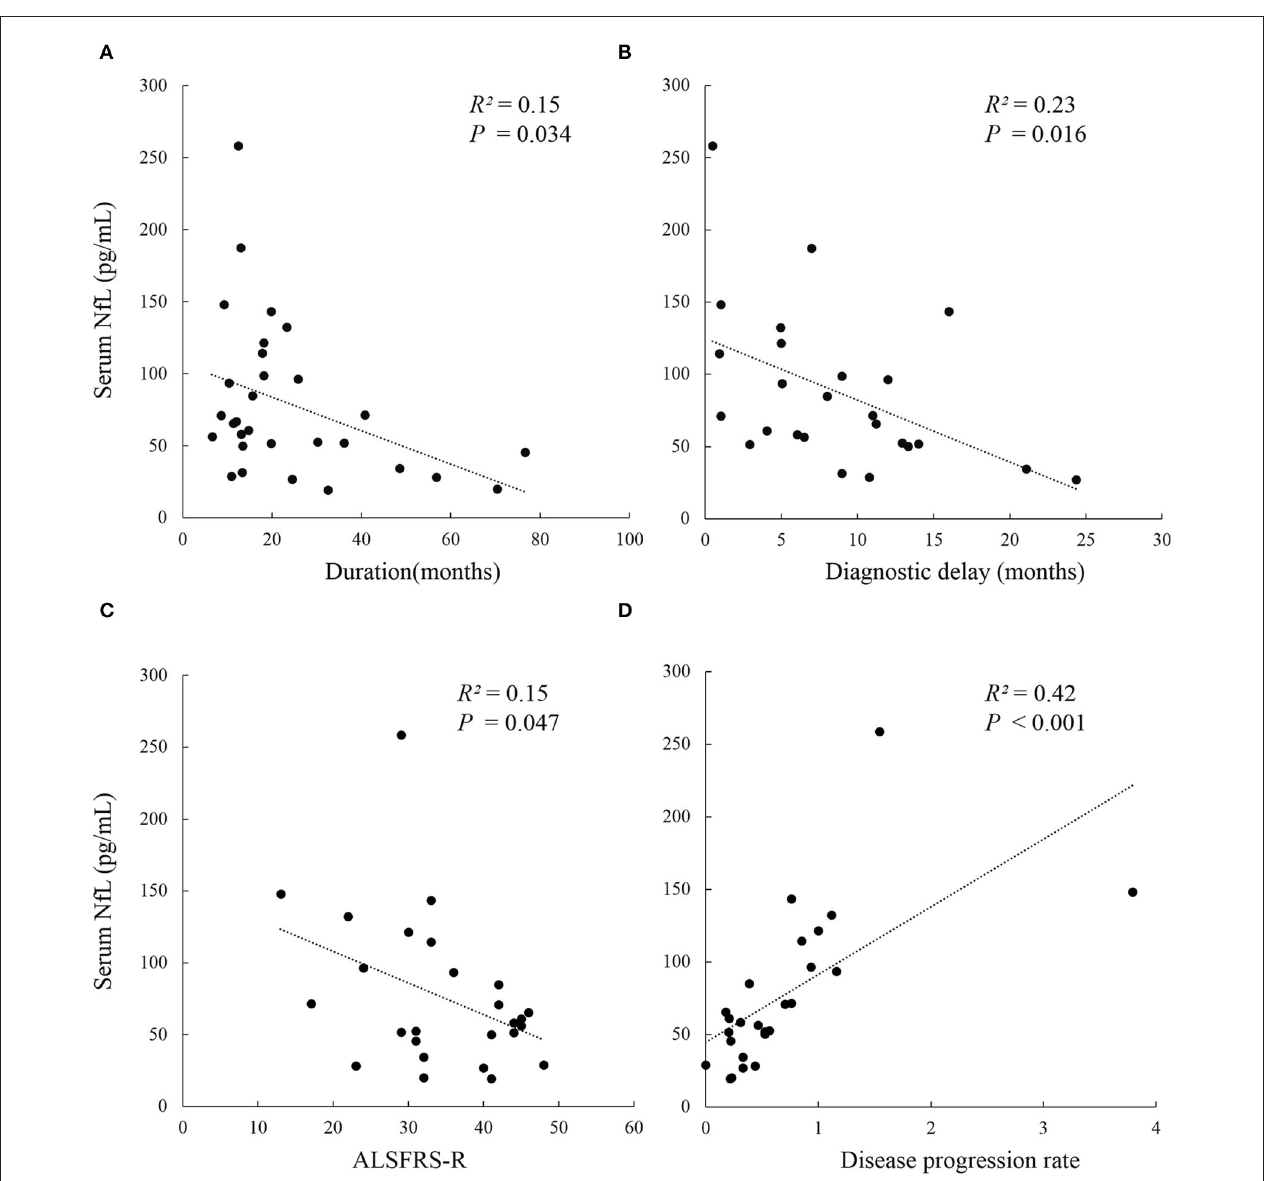
FIGURE 2 | Correlation analysis between serum NFL level and clinical parameters in Chinese patients with ALS. (A) Serum NFL level negatively correlated with disease duration ( R 2 = 0.15, P = 0.034); (B) Serum NFL level negatively correlated with diagnostic delay ( R 2 = 0.23, P = 0.016); (C) Serum NFL level negatively correlated with ALSFRS-r ( R 2 = 0.15, P = 0.047); (D) Serum NFL level positively correlated with the disease progression rate ( R 2 = 0.42, P < 0.001). ALS, Amyotrophic lateral sclerosis; ALSFRS-r, Amyotrophic lateral sclerosis functional rating scale revised; NFL, Neurofilament light chain.